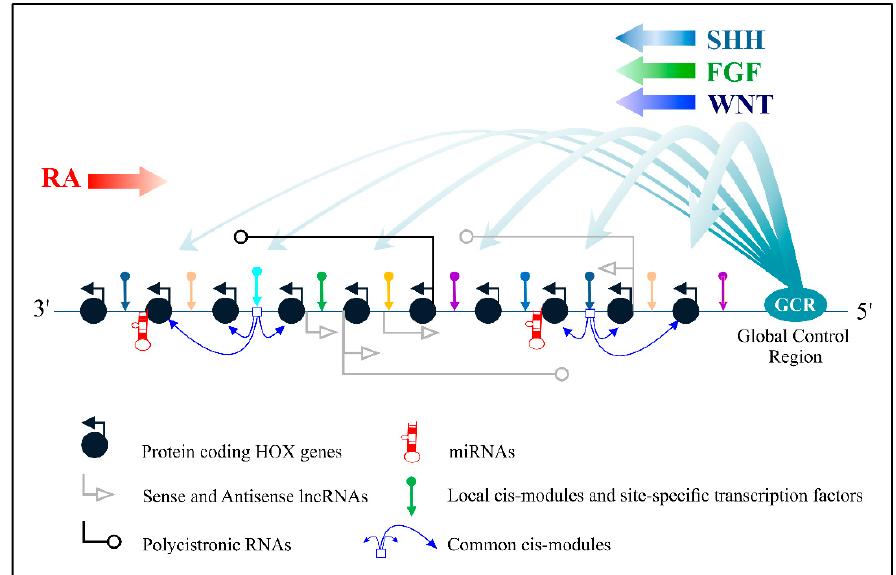
Figure 1. The main pathways for controlling the transcription of Hox genes. Large arrows indicate Retinoic acid pathway (RA), Sonic Hedgehog pathway (SHH), WNT and FGF pathways .